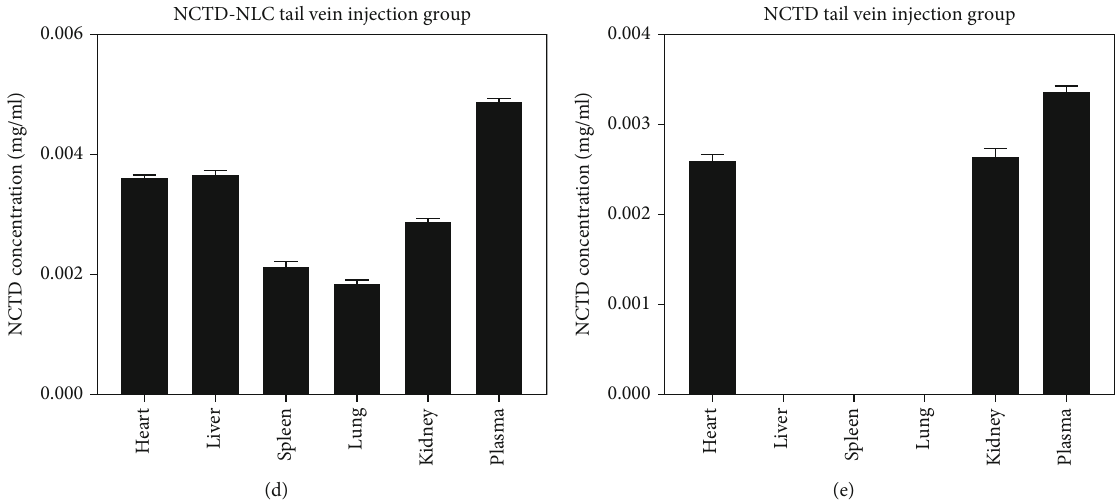
Figure 3: The HPLC detection onto the groups of NCTD-NLC gavage, NCTD gavage, NCTD-NLC tail vein injection, and NCTD tail vein injection to fi gure out the NCTD content in the heart, liver, spleen, lung, kidney, and plasma. (a) HPLC pro fi les. (b) The NCTD HPLC pro fi les of the heart, liver, spleen, lung, kidney, and plasma in the NCTD-NLC gavage group. (c) The NCTD HPLC pro fi les of the heart, liver, spleen, lung, kidney, and plasma in the NCTD gavage group. (d) The NCTD HPLC pro fi les of the heart, liver, spleen, lung, kidney, and plasma in the NCTD-NLC tail vein injection group. (e) The NCTD HPLC pro fi les of the heart, liver, spleen, lung, kidney, and plasma in the NCTD tail vein injection